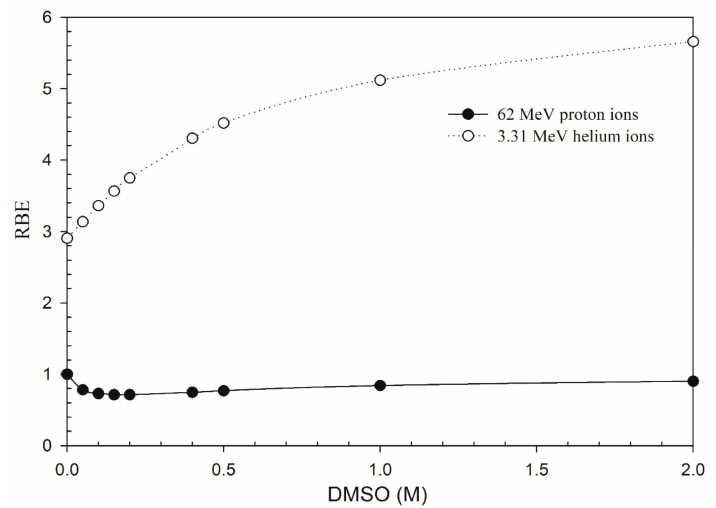
Figure 1. Relative biological effectiveness (RBE) as a function of the concentration of DMSO (0–2 M). Monte Carlo damage simulation (MCDS)-derived RBE values for DSB induction were shown for cells irradiated by 62 MeV proton ions (LET = 1.051 keV/ µ m) and 3.31 MeV helium ions (LET = 120 keV/ µ m).